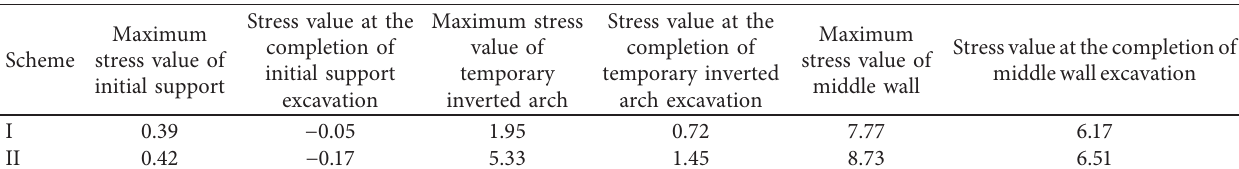
Figure 10: Time-history curve of initial support stress of 1-pilot tunnel. (a) Time-history curve of the initial support stress of 1-pilot tunnel in scheme II. (b) The comparison of time-history curve of the initial support stress of 1-pilot tunnel in the two schemes. Table 3: Stress value of each monitoring point of tunnel supporting structure unit: